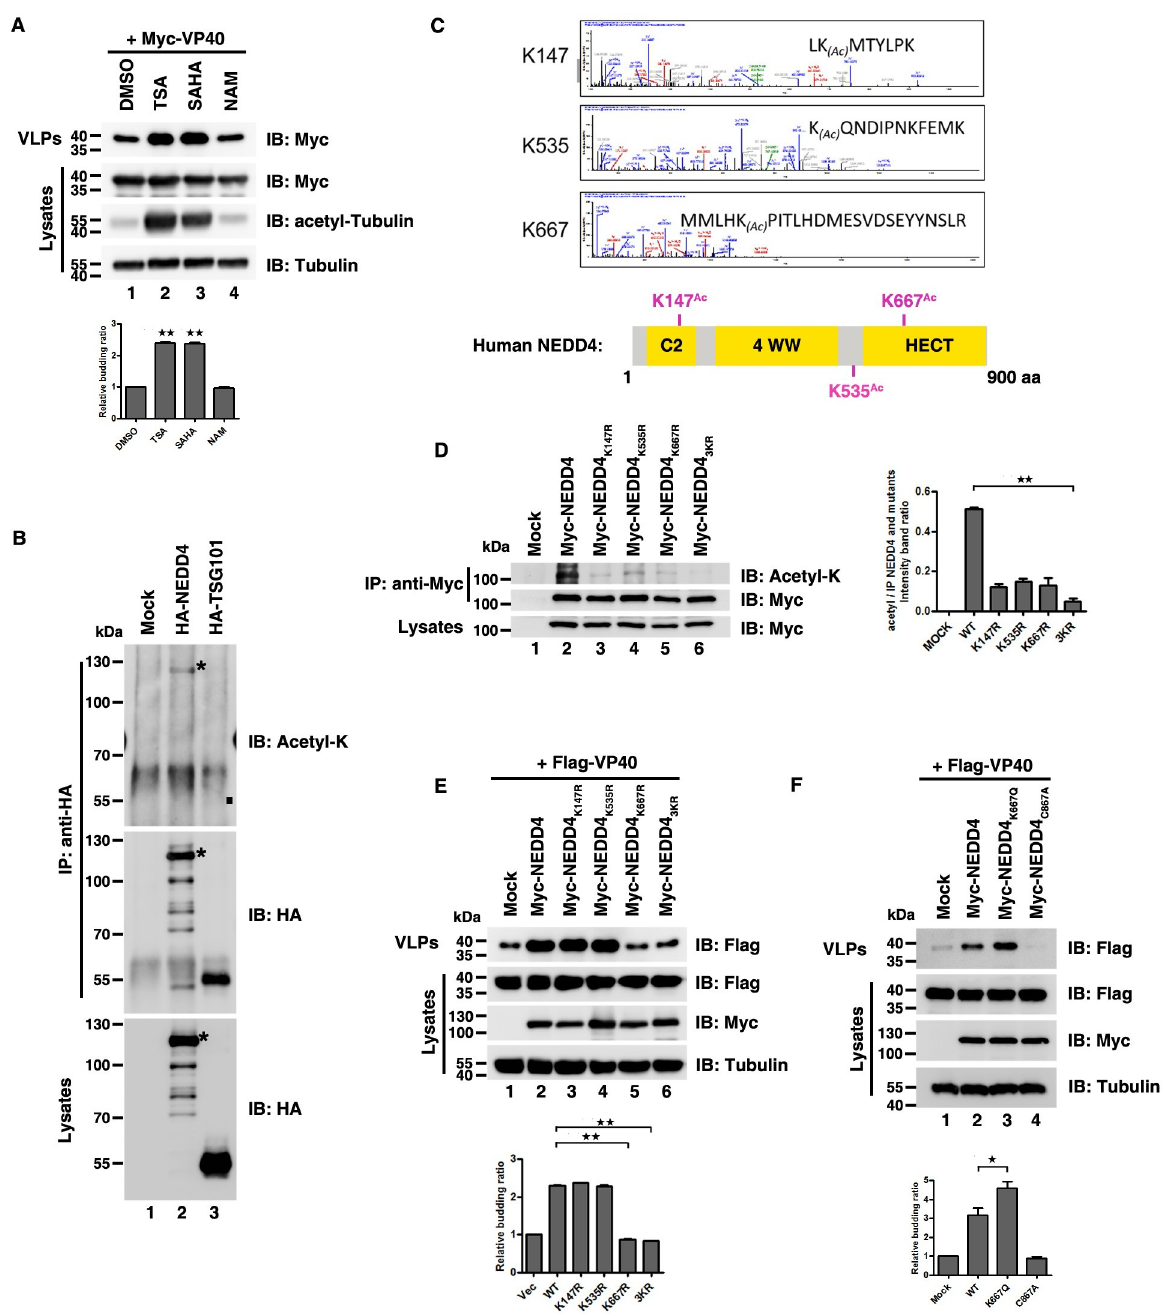
Fig 1. Acetylation-mimicking mutation of NEDD4 promotes VP40 budding. (A) HEK293T cells were transfected with Myc-VP40 for 40 hours and then treated with TSA, SAHA, and NAM for 8 hours and analyzed using the virus-like particle (VLP) assay. (B) HEK293T cells were transfected with indicated plasmids, immunoprecipitated with an anti-HA antibody and analyzed via immunoblotting with an anti-Acetyl-K antibody to detect the acetylation of NEDD4 and TSG101, where “ � ” indicated the specific NEDD4 and acetylation of NEDD4 and “ ■ ” indicated the location of the acetylation of TSG101. (C) NEDD4 acetylation sites were identified using mass spectrometry. Schematic diagram of the location of NEDD4 acetylation sites. (D) HEK293T cells were transfected with indicated plasmids, immunoprecipitated with an anti-Myc antibody and analyzed via immunoblotting with an anti-Acetyl-K antibody to detect the acetylation of the NEDD4 wild-type (WT) and mutants. (E)–(F) HEK293T cells were transfected with indicated plasmid combinations to detect the influence on the egress of VP40. Error bars, mean ± SD of three experiments. Student’s t test; � p < 0.05; �� p < 0.01; ��� p < 0.001.